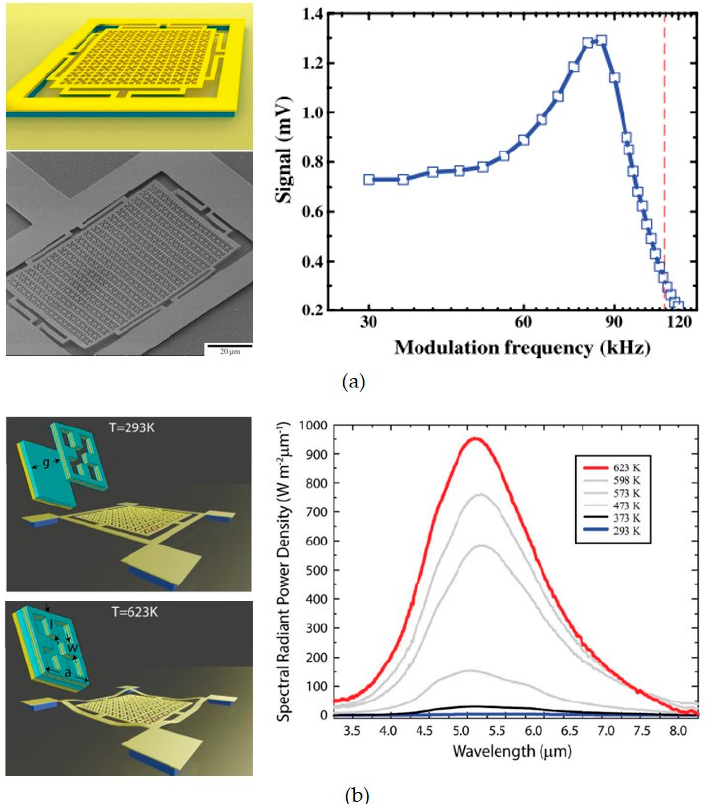
Figure 3. MEMS metasurfaces for controllable emission. ( a ) Controllable emitter driven by electrostatic force with maximum modulation speed of 110 KHz, the insets show schematic (up) and Scanning electron microscope (SEM) graph (down) for the emitter; ( b ) controllable emitter driven by